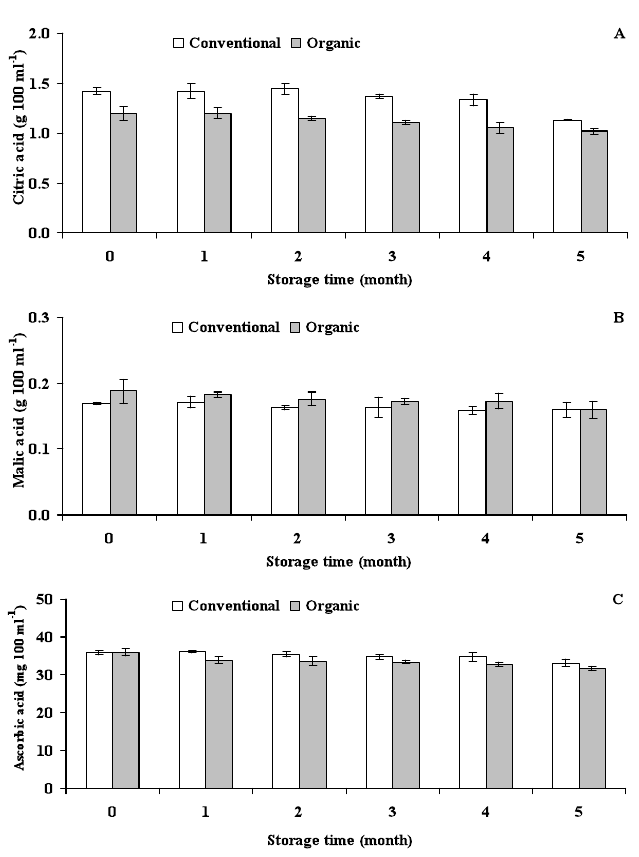
Fig. 6: Changes in organic acids content of conventionally and organically grown ‘Washington Navel’ oranges during storage at